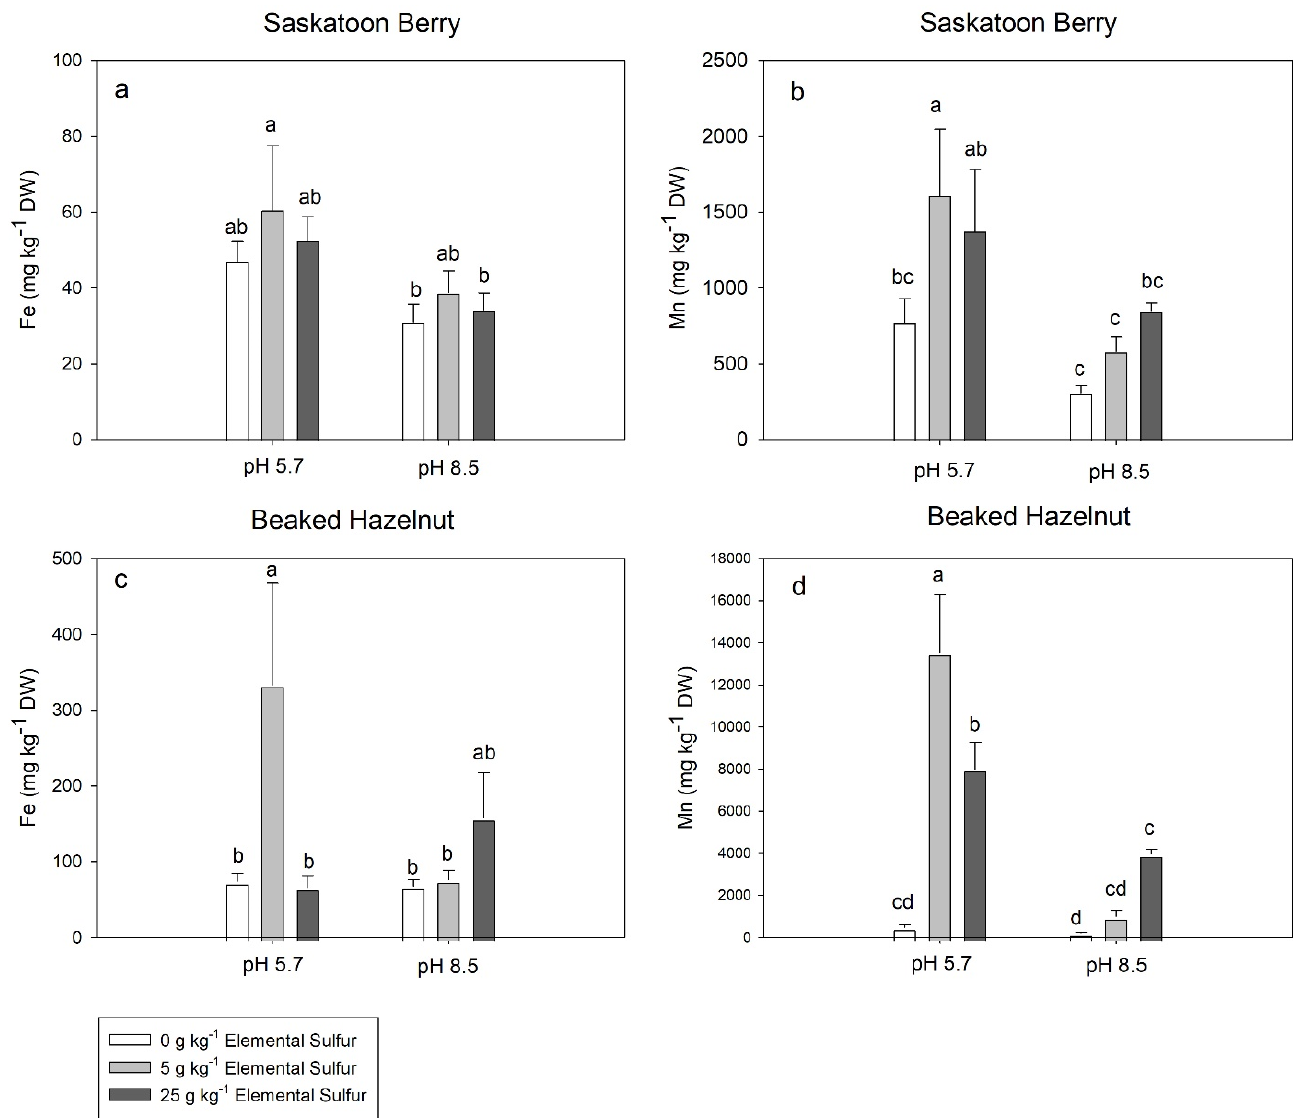
Figure 7. Leaf Fe and Mn concentrations in Saskatoon berry ( a , b ) and beaked hazelnut ( c , d ). Plants were grown for two months in the soil of the initial pH 5.7 and 8.5 that was supplemented with 0, 5, and 25 g kg − 1 elemental S. Different letters above the bars indicate significant differences ( α = 0.05) between treatments determined by Tukey HSD test. Means ( n = 6) ± SE are shown.